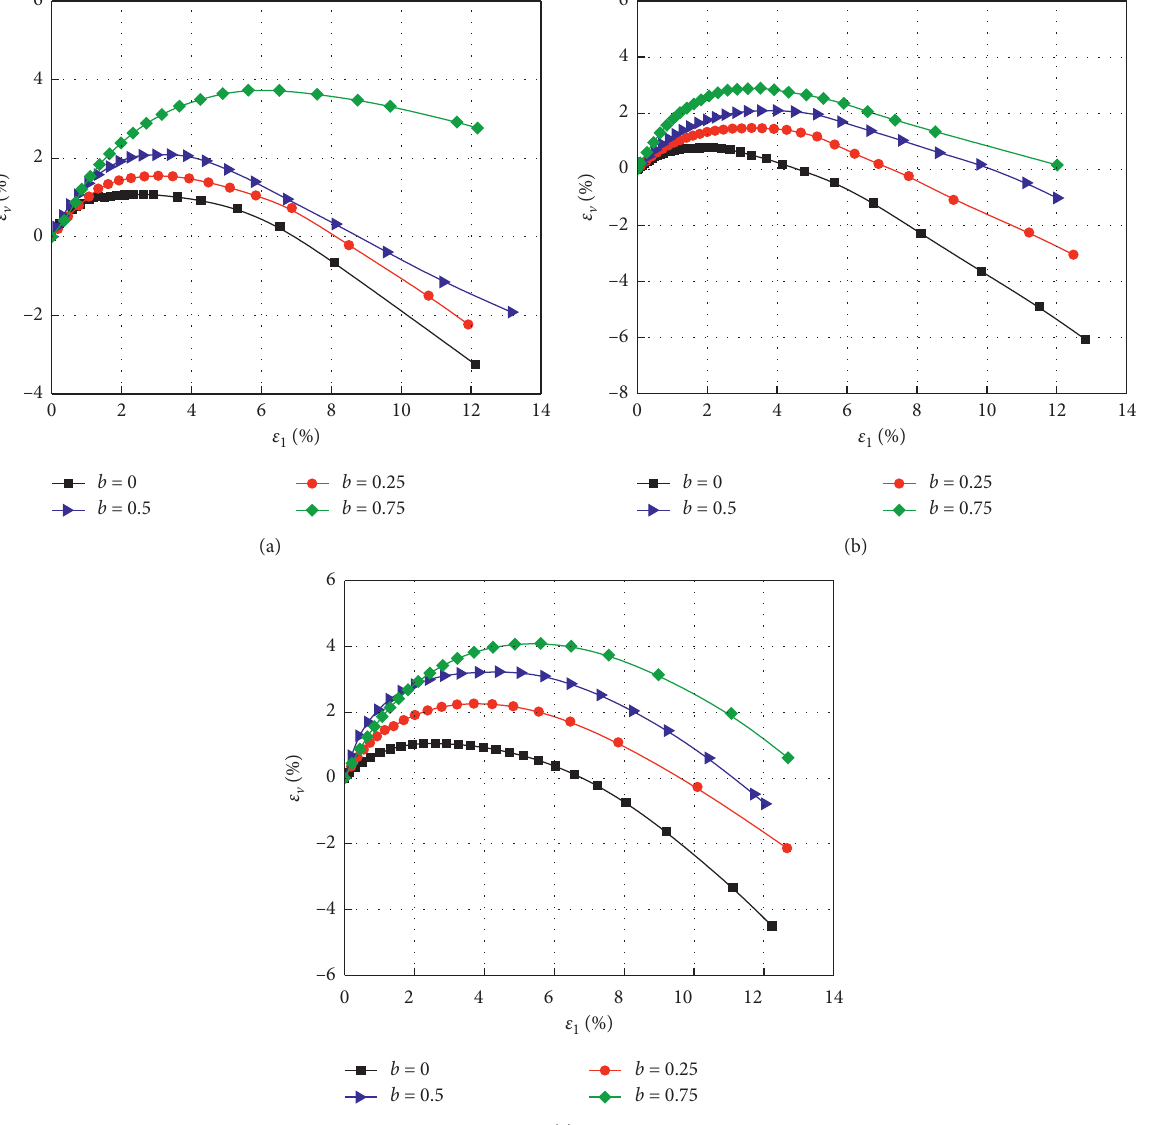
Figure 6: Curves of strain compared to large principal strain in frozen sand at different temperatures. (a) − 5 ° C. (b) − 10 ° C. (c) − 15 °